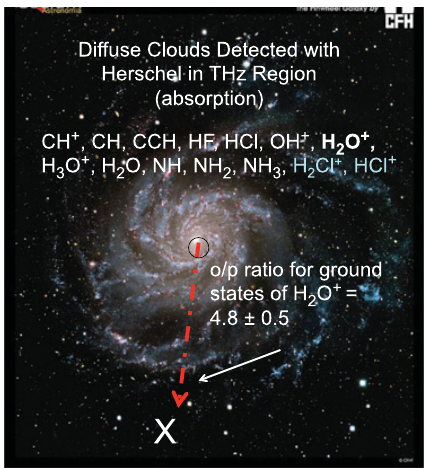
Figure 1. Absorption of far-infrared radiation from the center of our galaxy by diffuse clouds in the spiral arms. Note that the actual picture is of another spiral galaxy, the pinwheel galaxy, for purposes of illustration. Molecules detected by Herschel Space Observatory. Credit for CFHT Image: Canada–France–Hawaii Telescope/ J.-C.